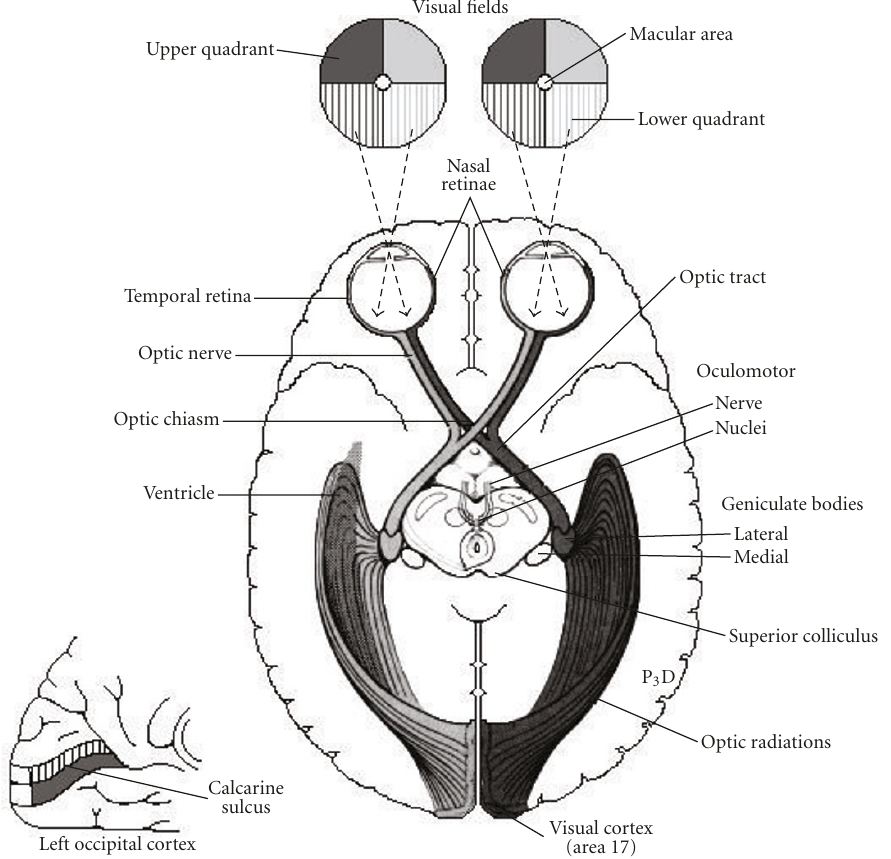
Figure 1: Illustration of the optic nerve, lateral geniculate nucleus (LGN) and V1 (area 17 in the figure), obtained from